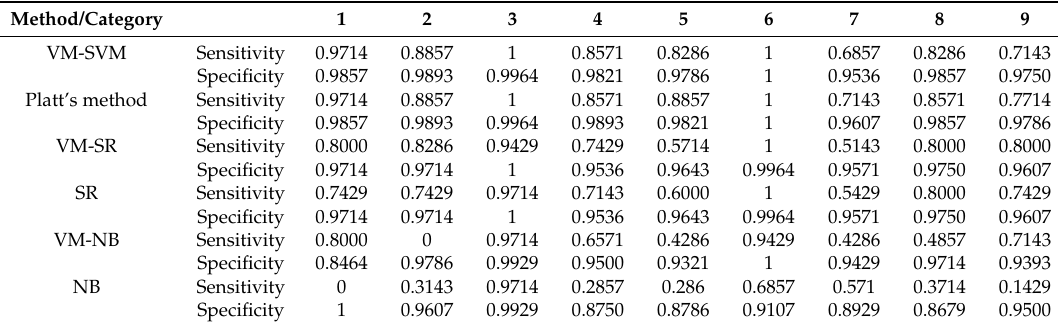
Table 3. Sensitivity and specificity for each category with each